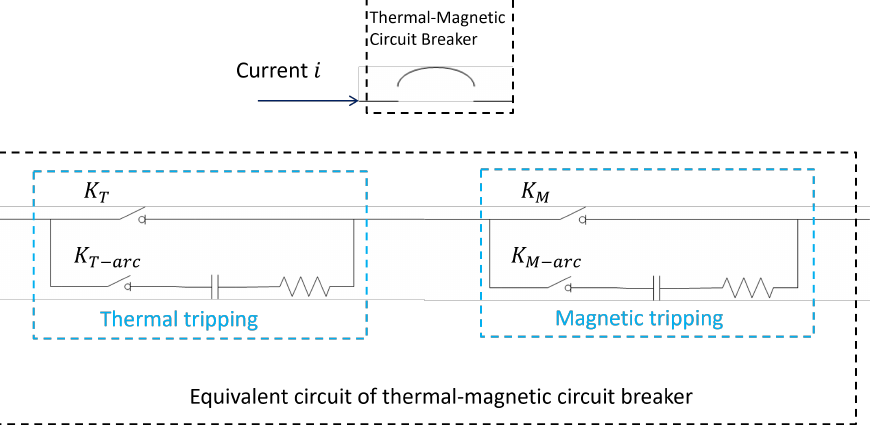
Figure 2. Equivalent circuit of